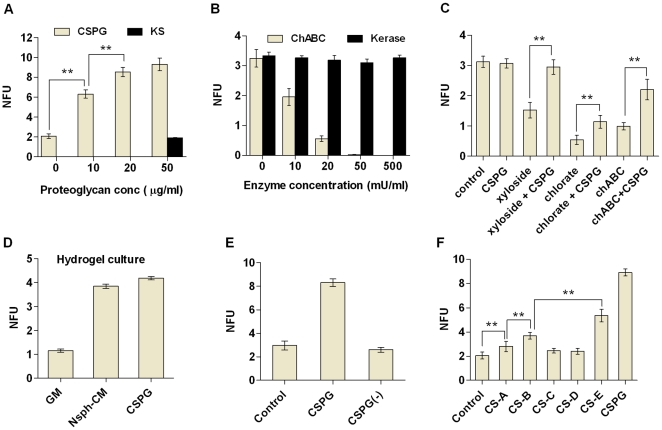
Specificity of CSPG mediated stimulation of nsph formation.Cells were plated at 2×103 cells/ml and NFUs measured after five days of culture as described in figure 1 (except D). Data shown in the bar charts (A–F) examine the effect of the following on NFUs; (A) CSPG (10–50 µg/ml) and keratin sulfate (KS; 50 µg/ml). (B) ChABC (10–50 mU/ml) and keratinase (Kerase; 10–500 mU/ml). (C) GM, CSPG (50 µg/ml); xyloside (150 µM), chlorate (50 mM) and chABC (50 mU/ml) with and without CSPG (50 µg/ml). (D) The effect of GM, nsph-CM and CSPG (50 µg/ml) on NFUs measured in hydrogel. Cells were plated at 2.5×103 cells/ml in hydrogel medium (see Material & Methods) and NFU measured after five days. (E) Nsphs grown in the presence of CSPG were dissociated and replated at 2×103 cells/ml with and without CSPG (50 µg/ml). Secondary nsph formation was evaluated after five days. (F) GM, CSPG (50 µg/ml), chondroitin sulfate A–E (CS-A to CS-E; all at 50 µg/ml). Data are presented as mean ± SEM with n = 3–12 (from 2–4 experiments); ** P≤0.01.